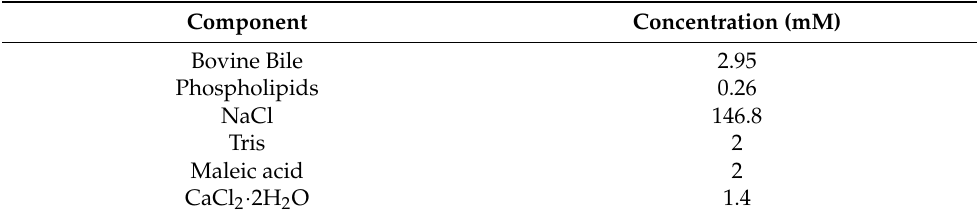
Table 1. Composition of simulated intestinal in vitro lipolysis medium (SIM)